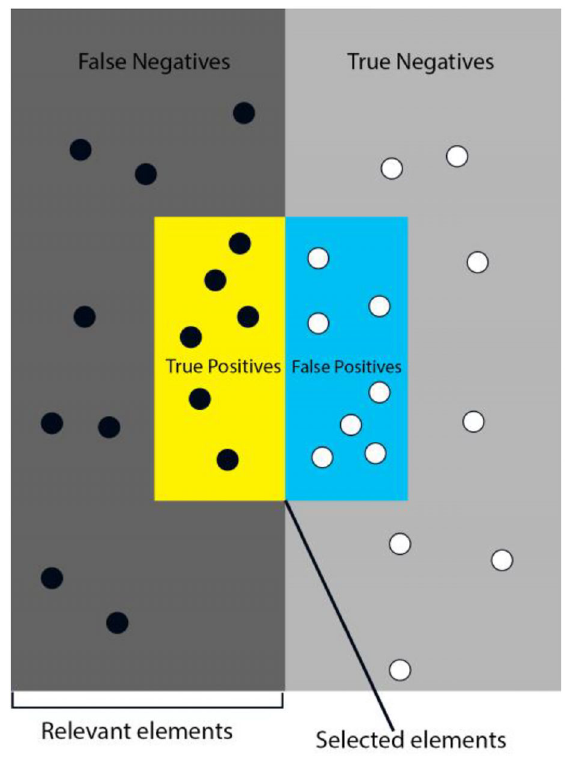
Fig. 5. Pixels detection as True Positive, True Negative, False Positive, and False